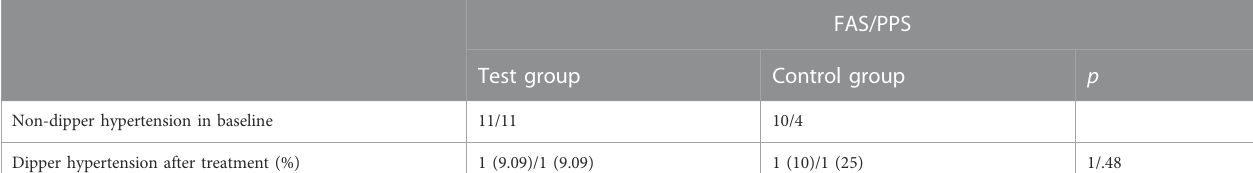
TABLE 3 Percentage of patients with circadian restoration.